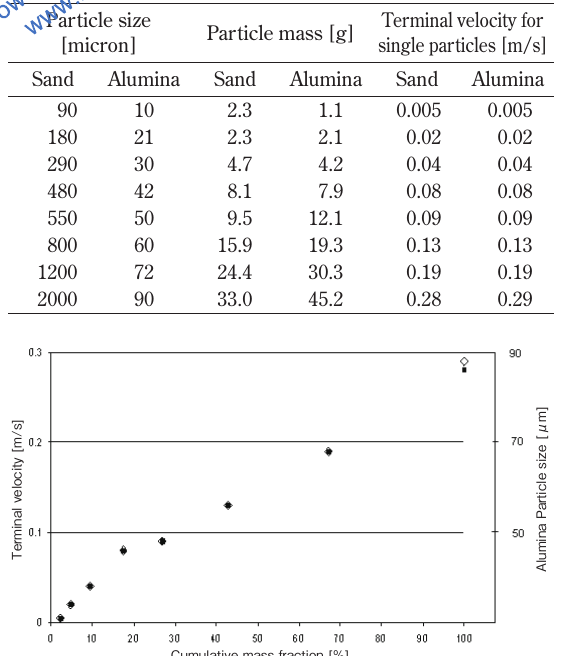
Table 1 Particle fraction of alumina and sand, and the corresponding single particle terminal velocities Particle size [micron]